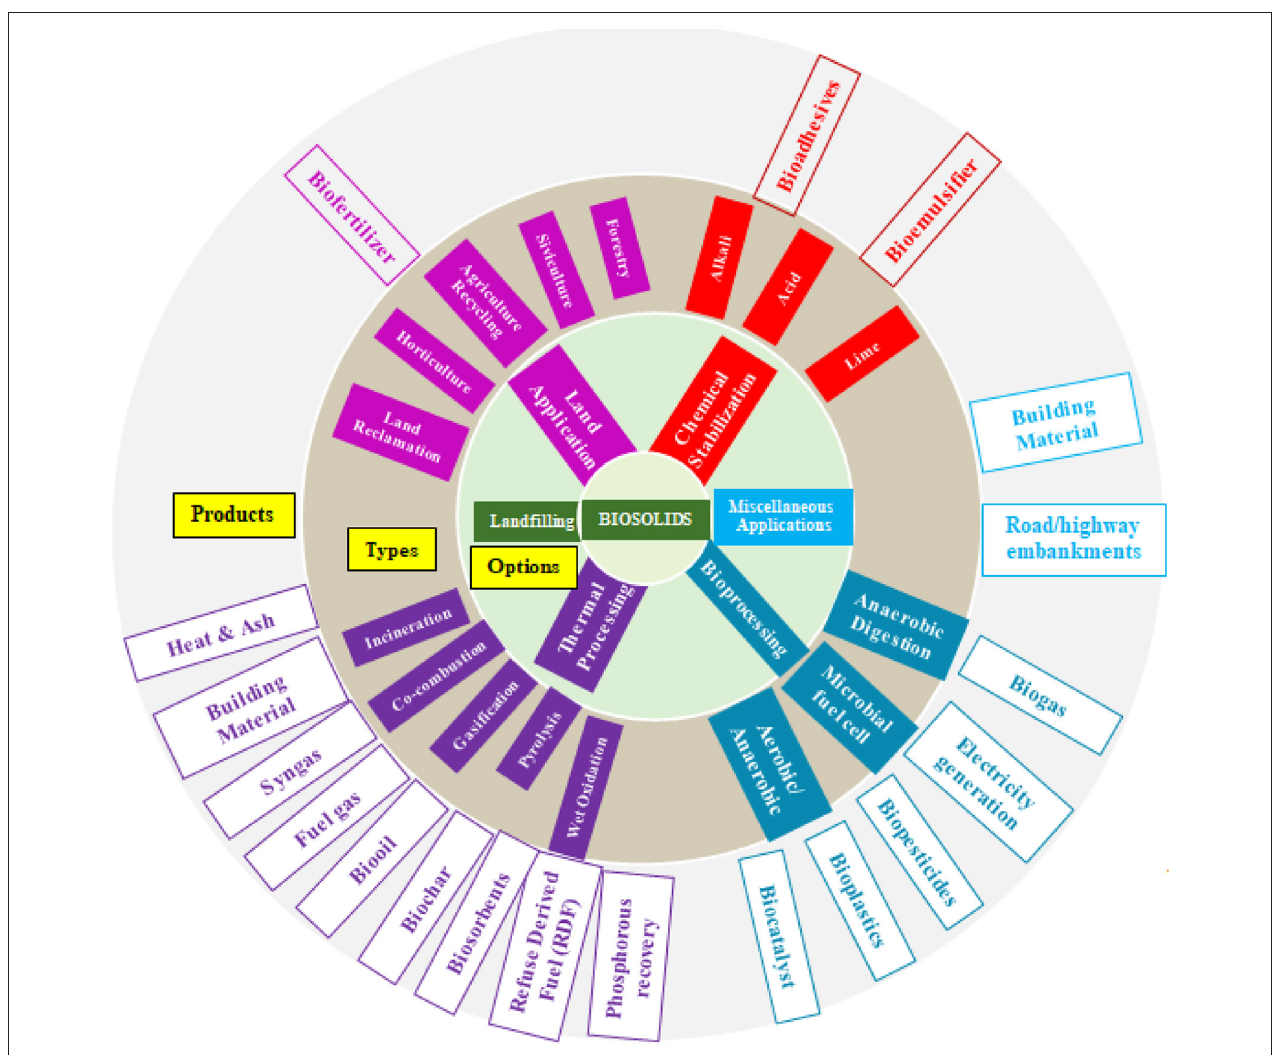
FIGURE 1 | Different solid waste management options for biosolids (Adapted from Sharma et al.,